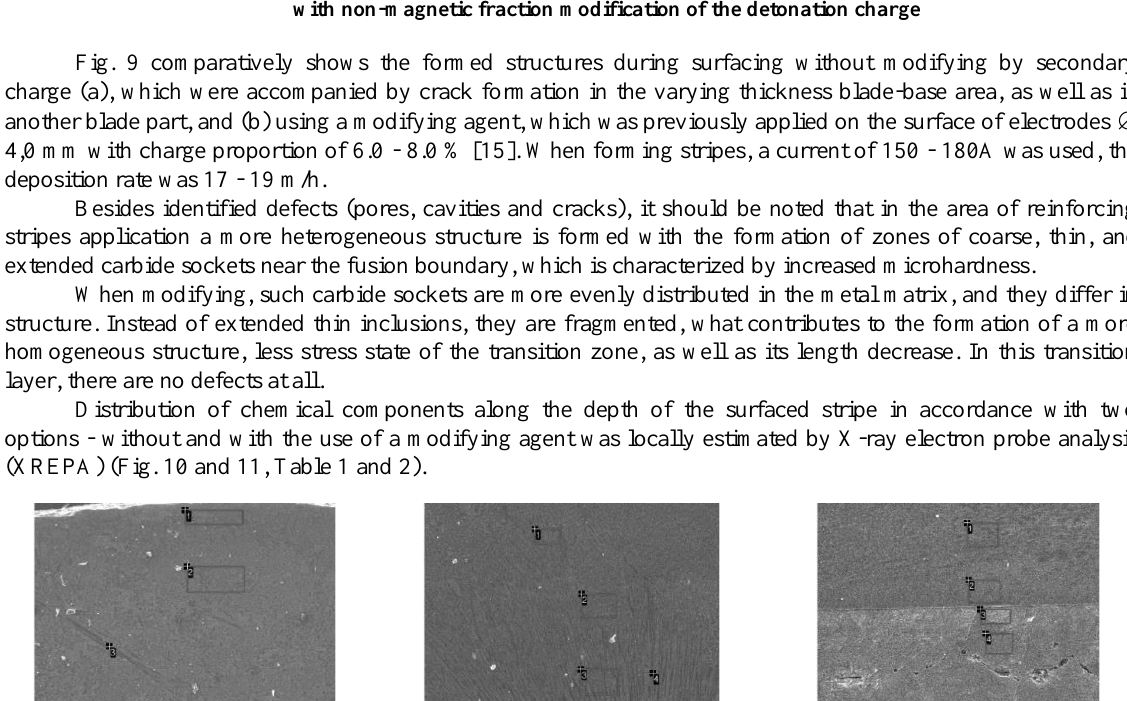
Fig.9. Microstructure over the section of samples: a - surfacing with T-620 electrode; b - surfacing with T-620 electrode with non-magnetic fraction modification of the detonation charge